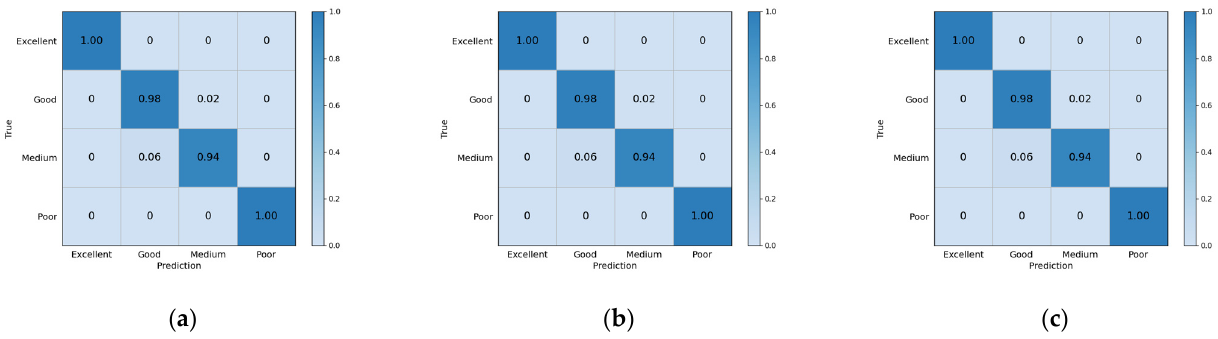
Figure 9. Confusion matrix for boys’ physical fitness level evaluation. ( a ) Confusion matrix when epoch is 250; ( b ) Confusion matrix when epoch is 300; ( c ) Confusion matrix when epoch is 350.